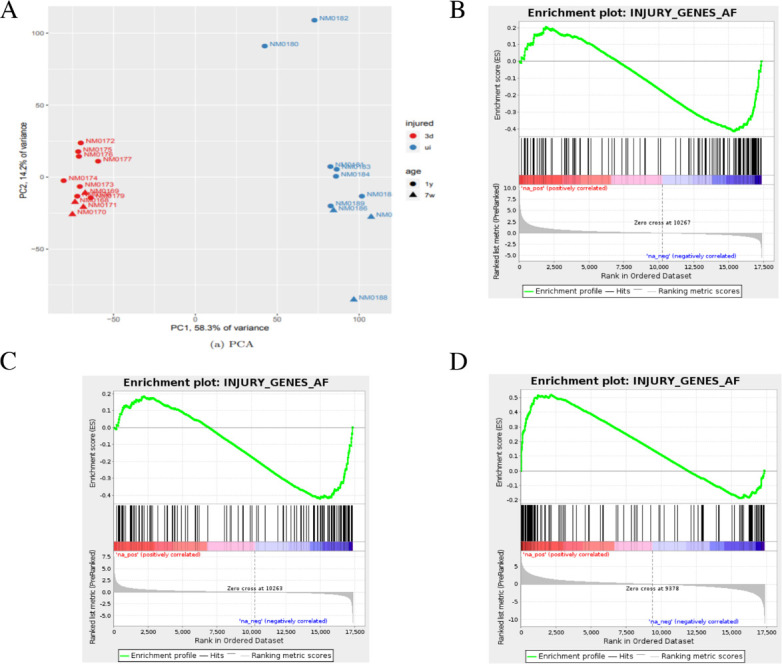
Bioinformatics analysis of aged and young nerves following injury.(A) Principal component analysis (PCA) shows that the key source of variance in our aging analysis is injury status with samples clustering together after injury (red) regardless of age or genotype. (B) Gene set enrichment analysis (GSEA) of uninjured young and aged WT nerves showed enrichment in the downregulation of c-Jun-regulated genes in aged nerves. Normalized enrichment score (NES) = −1.85, q-value = 0.0. (C) GSEA analysis comparing injured old and young nerves showed a similar enrichment of c-Jun genes in the downregulation of these genes, suggesting a failure of c-Jun regulation in aged nerves. NES = −1.61, q-value = 0.0. (D) GSEA of young and aged nerves compared to their uninjured controls and then to each other to examine the differential expression between the two in response to injury. Analysis shows that c-Jun gene upregulation was highly enriched by injury. NES = 2.01, q-value = 0.0.